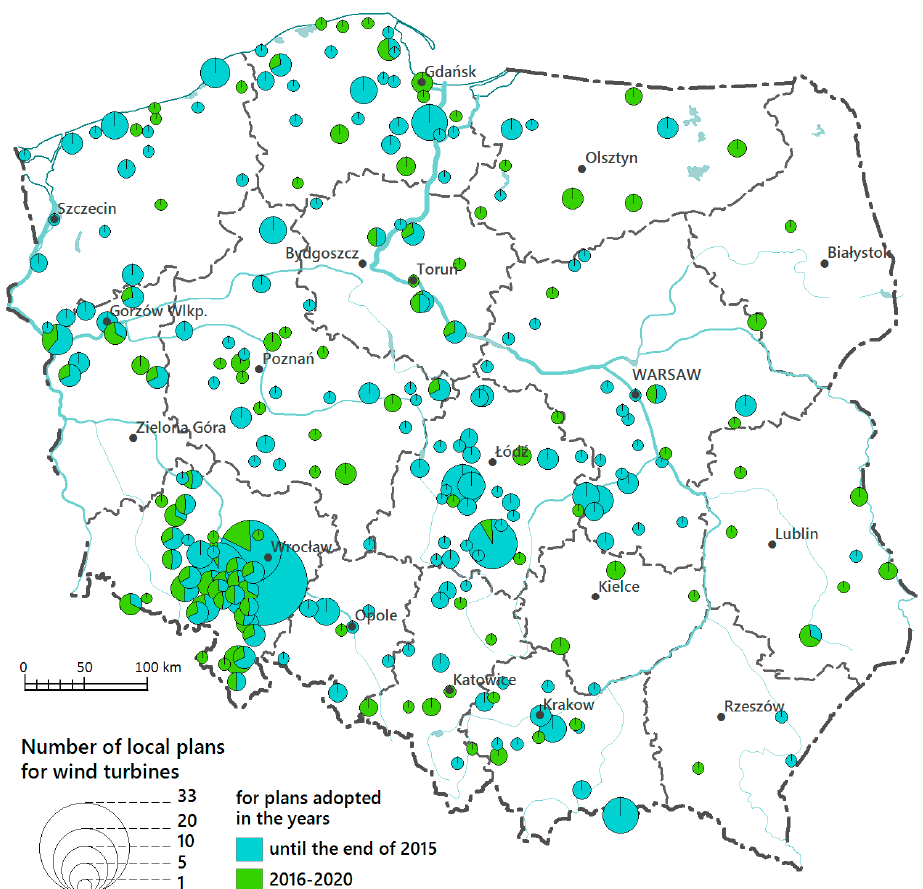
Figure 3. Location of local plans for wind farms in late 2020. Table 2. Characteristics of local plans in terms of arrangements concerning renewable energy sources.